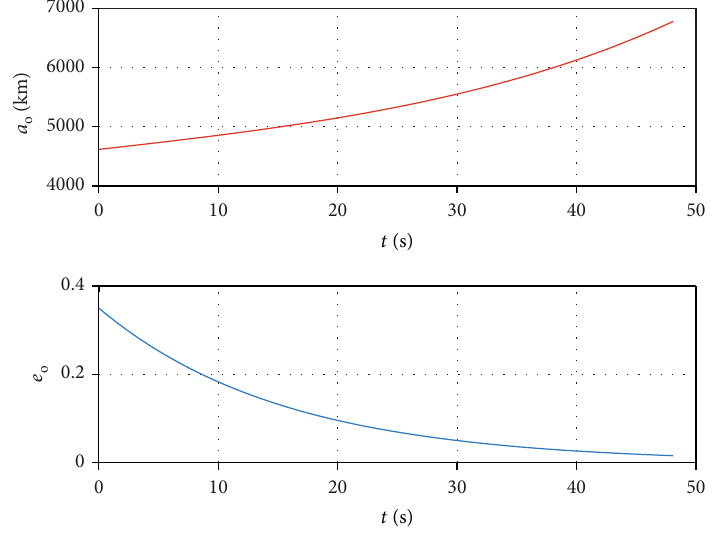
Figure 6: The orbital semiaxis and